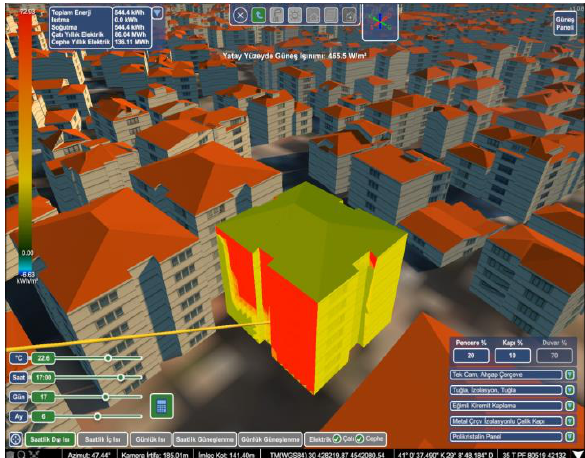
Figure 9. Selection of a particular building to be